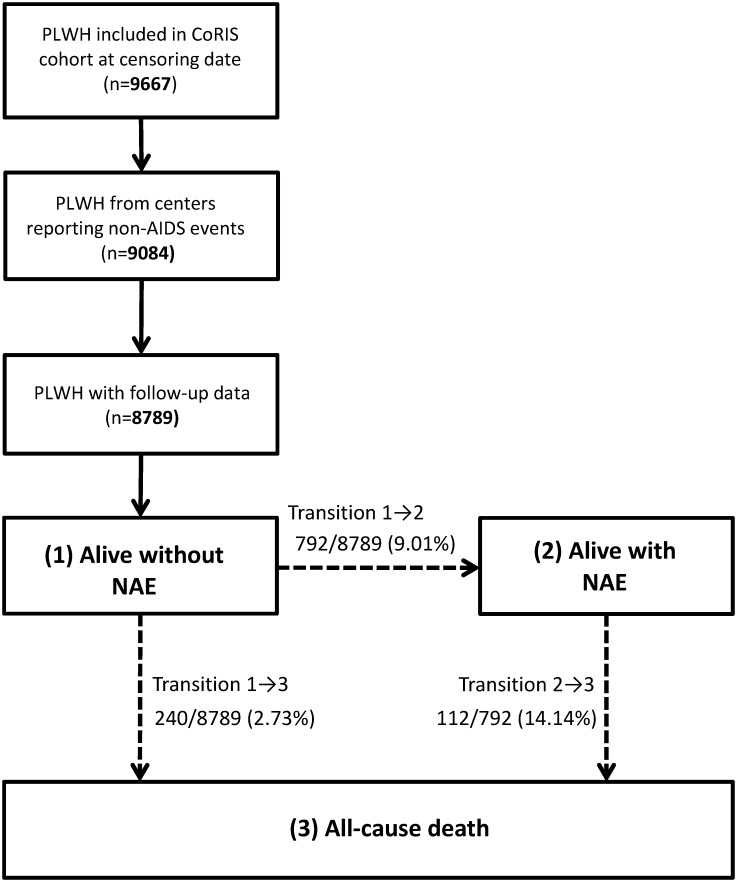
Multi-state model of non-AIDS event (NAE) development and all-cause mortality.Three possible states are considered: (1) alive without NAE, (2) alive with NAE, (3) death. Number (%) of patients for each transition; for transition 2→3 (death after NAE), the percent is calculated using the number of patients who previously reached state 2 (Alive with NAE).